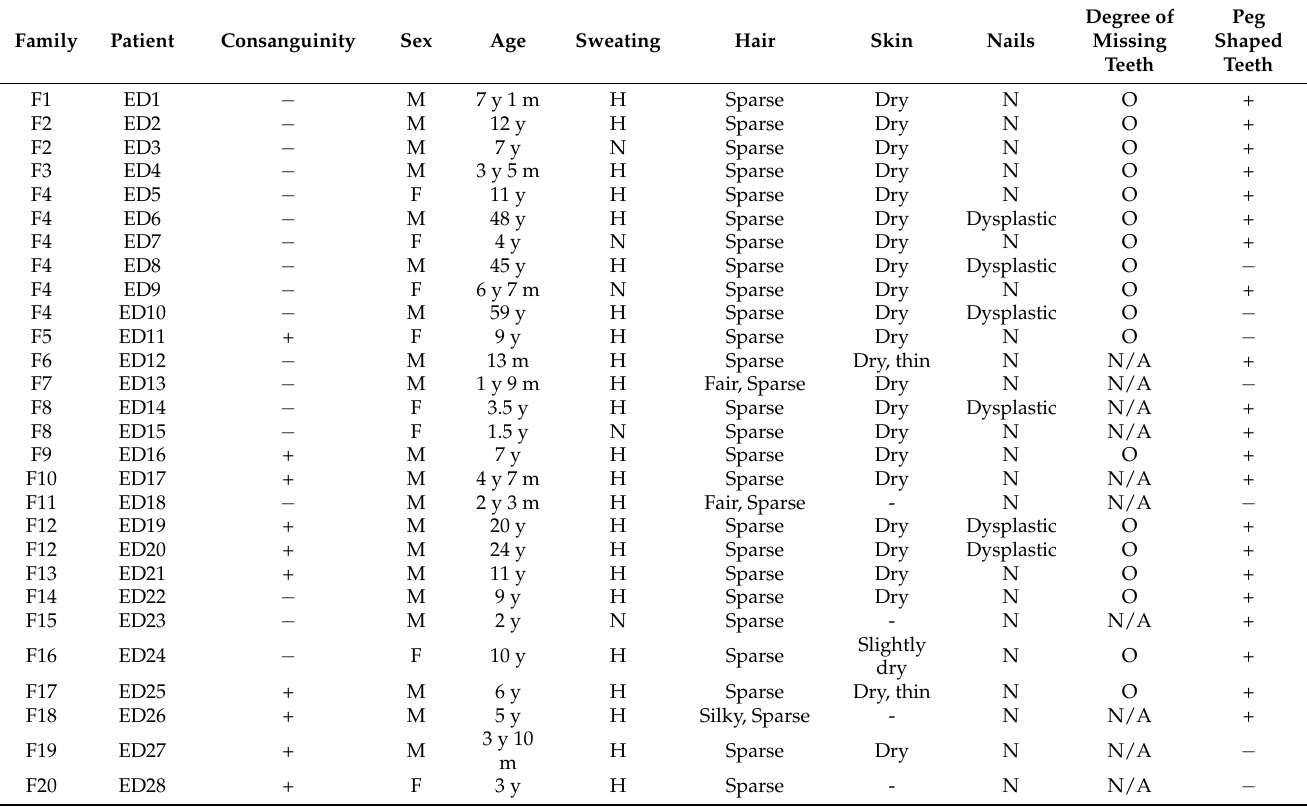
Table 2. Clinical data of molecularly identified ED